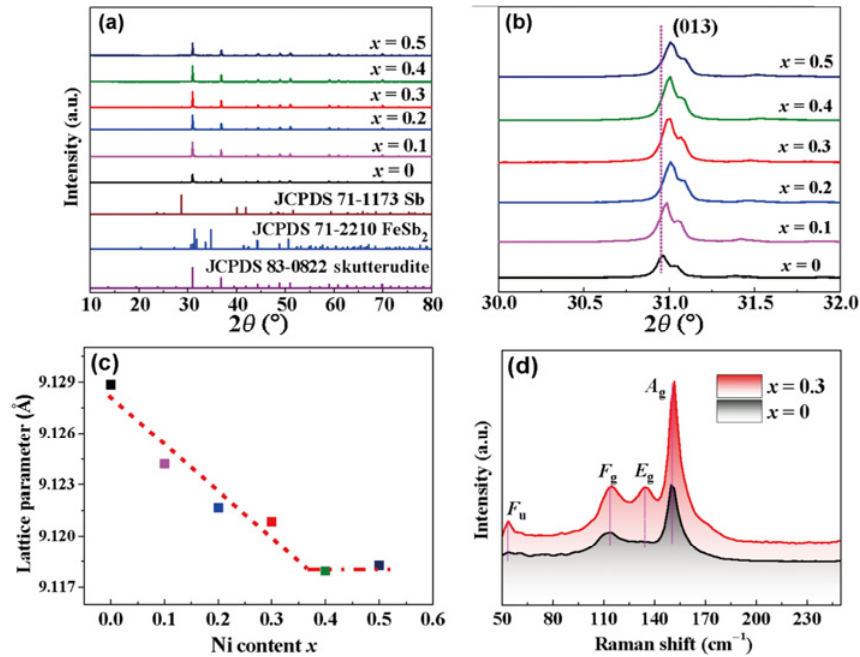
Fig. 2 (a, b) XRD patterns and (c) lattice parameters of CeFe 3.8 − x Ni x Co 0.2 Sb 12 ( x = 0, 0.1, 0.2, 0.3, 0.4, and 0.5) samples. (d) Raman spectra of CeFe 3.8 − x Ni x Co 0.2 Sb 12 ( x = 0 and 0.3)